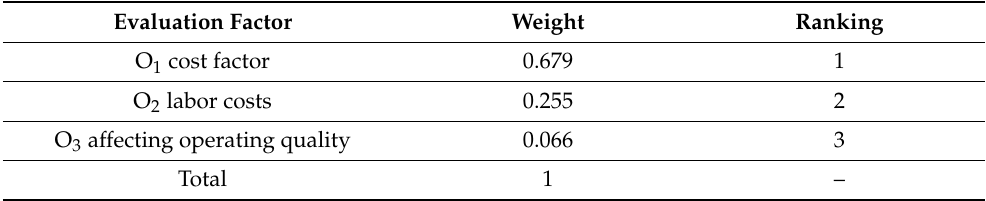
Table 3. The weight and ranking of evaluation factors in the 2nd layer with the electromechanical system as an